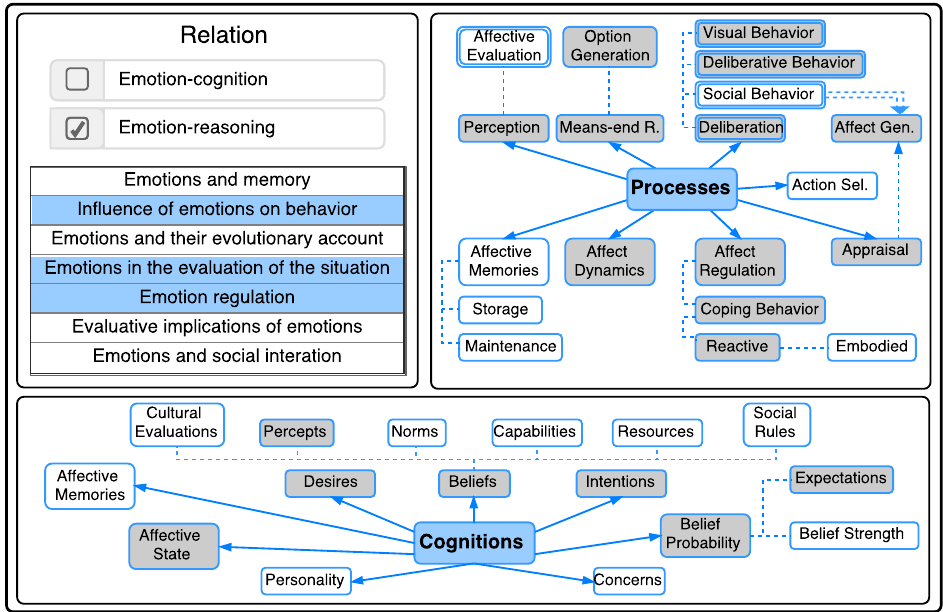
Figure 4. Processes and cognitions of the WASABI